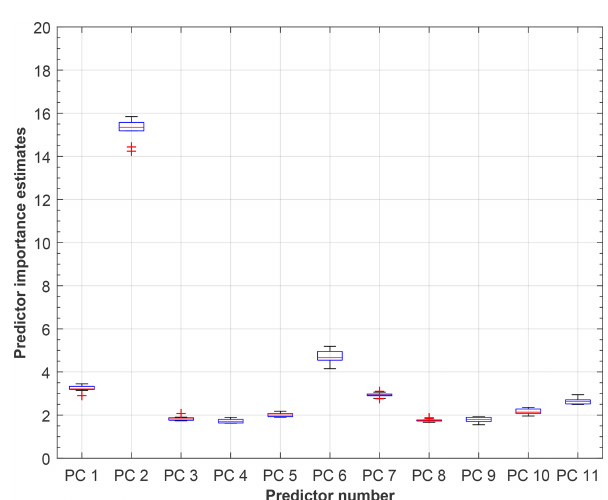
Figure C2. Estimates of predictor importance derived from the ran- dom forest model using the PCs as model input (see Table C1), encompassing 10000 observations composed of equal numbers of spherical and aspherical particles, randomly pulled from the entire calibration data set. The random forest model was grown on 200 in- dependent decision trees and predictor importance was derived from a curvature test for predictor splitting (Loh and Shih, 1997) using the OOB samples. Each box encompasses a total of 10 independent simulations (random forest models), with the red line representing the median and the bottom and top edges of the box indicating the 25th and 75th percentiles, respectively. Whiskers extend to the most extreme data points that are not considered as outliers, which are given by the red